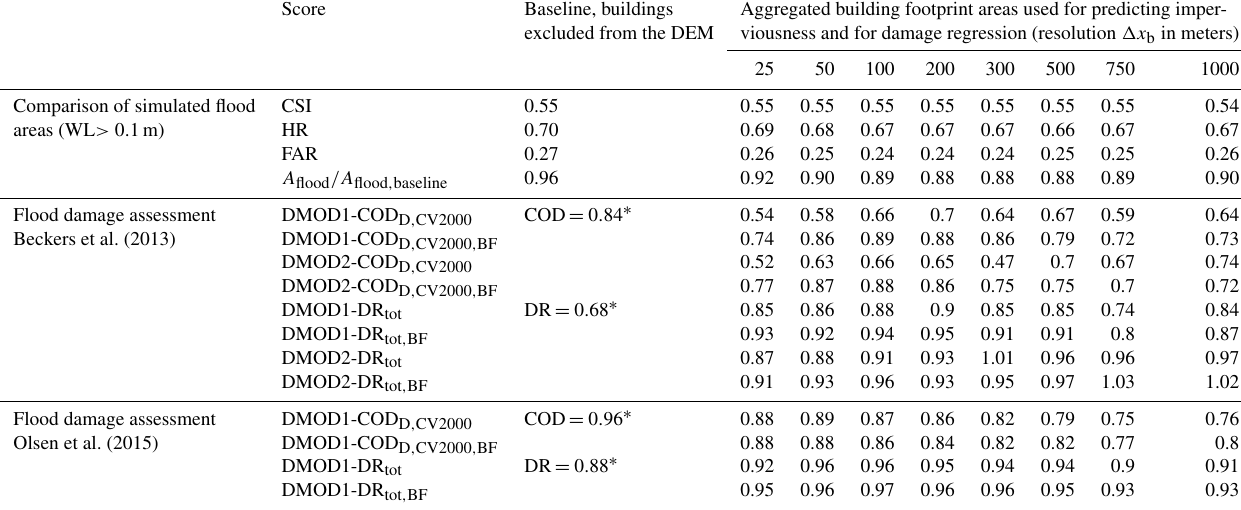
Table 2. Summary scores for return period T = 20 years. The top section compares flood areas simulated with the varying input datasets to the baseline simulation. The middle and lower sections evaluate goodness of fit for the damage regression models, considering separate results for the two damage assessment frameworks. Values shown for COD D and DR tot correspond to median values obtained during cross validation. The subscript BF marks those cases were flood areas from the baseline simulation were used to determine flooded building areas for regression. Score values for damage regression were derived at a fitting resolution (cid:49)x fit = 1000m.